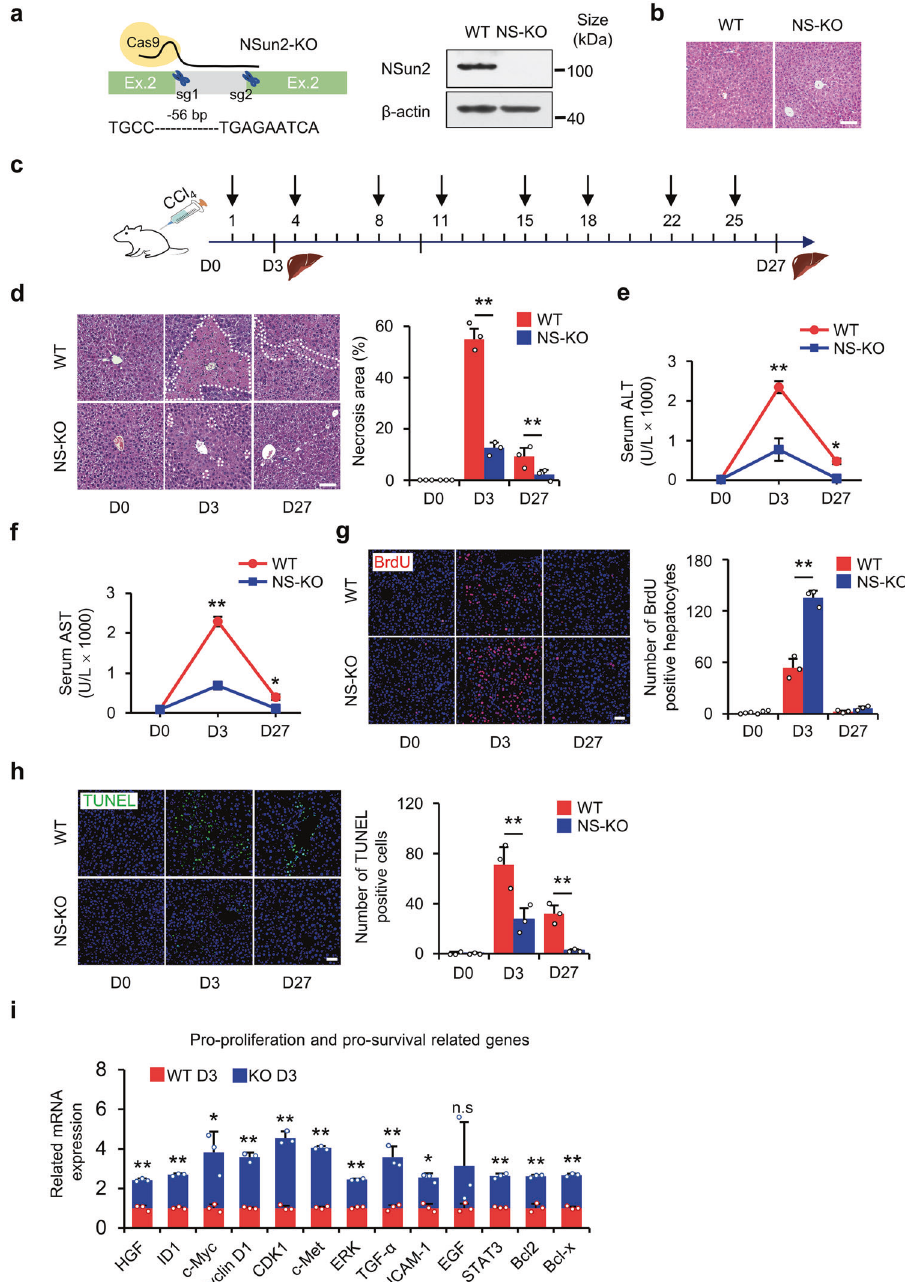
Fig. 2 NS-KO improves liver necrosis, regeneration, and survival in vivo. a Generation of NS-KO mice. Left panel showing a schematic representation of NS-KO mice, NSun2 genomic locus, and NSun2 deleted locus. The targeting sgRNA was designed to knock out 56 bp DNA fragments in exon 2 of the NSun2 gene. The right panel is genotyping analysis of WT and NS-KO mice con fi rmed by western blotting. b H&E staining showing mouse liver in WT and NS-KO mice not subjected to stress. Scale bar, 50 μ m; n = 3 mice. c Schematic of the construction of liver injury mice models. Liver injury was induced by repeated injections of CCl 4 . The part above the arrow line of time represents the injection time, and the part under the arrow line represents the liver-obtained time. D0: no injury; D3: day 3 after injury; D27: day 27 after injury. d H&E staining showing hepatic necrosis at different time points after CCl 4 injection. Dotted lines indicate the necrotic or in fl ammatory area and the percentage of the necrotic or in fl ammatory areas is quanti fi ed. Scale bar, 50 μ m; n = 3 mice. e , f Mouse serum ALT ( e ) and AST ( f ) concentrations were assessed to determine the degree of liver injury after repeated CCl 4 injection, n = 4 mice. g Hepatocytes proliferation in liver sections. Three hours before the mice were euthanized, 5-bromodeoxyuridine (BrdU) incorporation was performed for WT and NS-KO mice treated with CCl 4 and BrdU-positive hepatocytes were quanti fi ed. Scale bars, 200 μ m; n = 3 mice. h TdT-mediated dUTP nick end labeling (TUNEL) assay on liver sections of WT mice or NS-KO mice treated with CCl 4 . Green cells indicate TUNEL-positive (apoptotic) cells. Nuclei were stained with DAPI, and TUNEL-positive nuclei were quanti fi ed. Scale bars, 200 μ m; n = 3 mice. i Proliferation- and survival-related gene expression was quanti fi ed by qRT-PCR after liver injury. n = 3 mice. For data in this fi gure, representative images are shown. All data are presented as the mean ± SD. * P < 0.05, ** P < 0.01, Student ’ s t -test